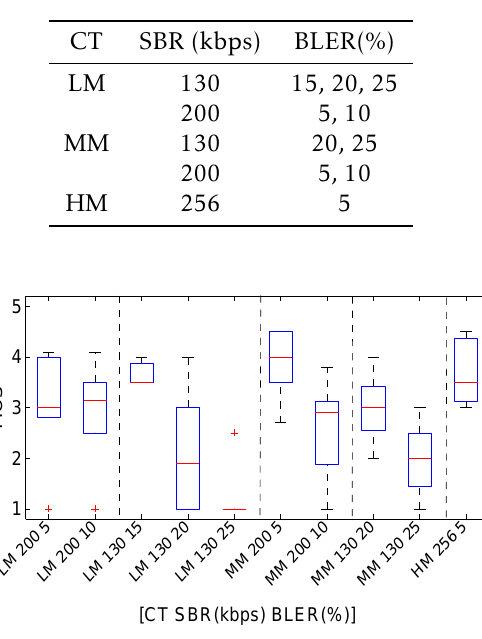
Table 6. SBR and BLER settings for subjective tests.